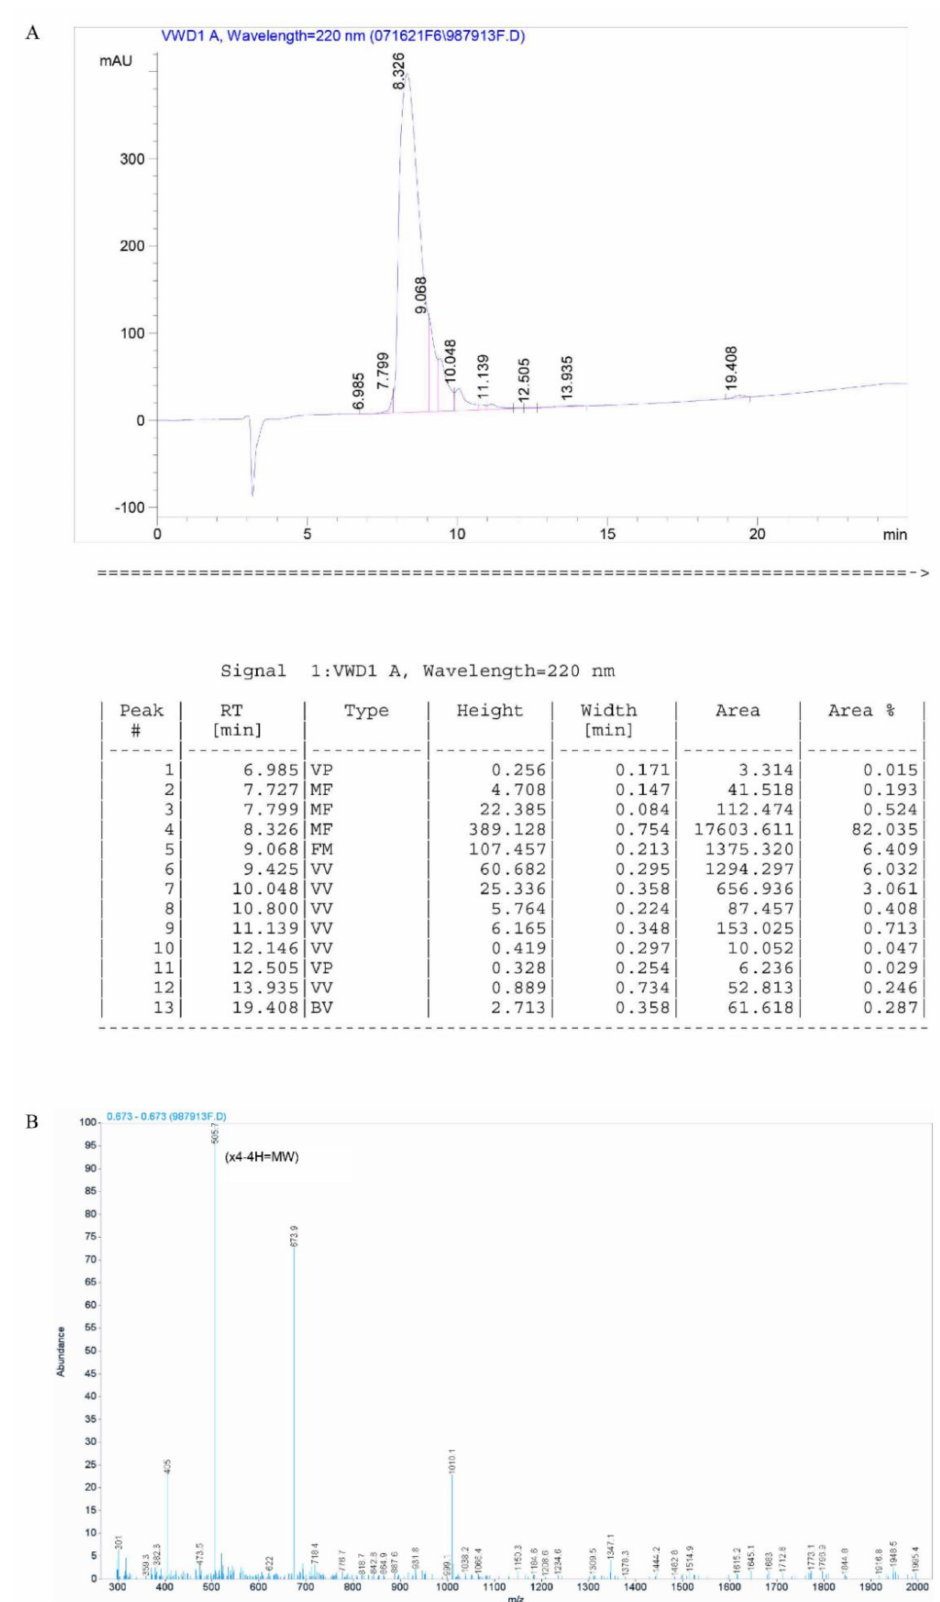
Figure 2. HPLC and Mass Spectrometry analysis of peptide DRF3. ( A ) HPLC analysis of peptide DRF3; ( B ) Mass Spectrometry analysis of peptide